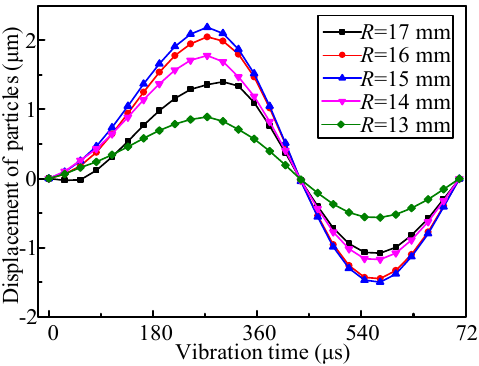
Figure 5. The displacement-time relation curves of particles with different radial position on the fluid-structure interface ( R is the radius of the particle’s position).